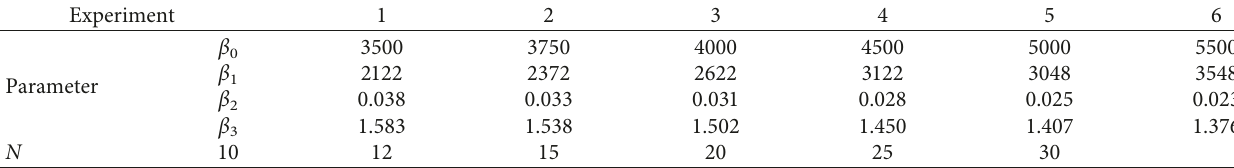
Table 1: Initial values for the parameters of the Weibull growth model.